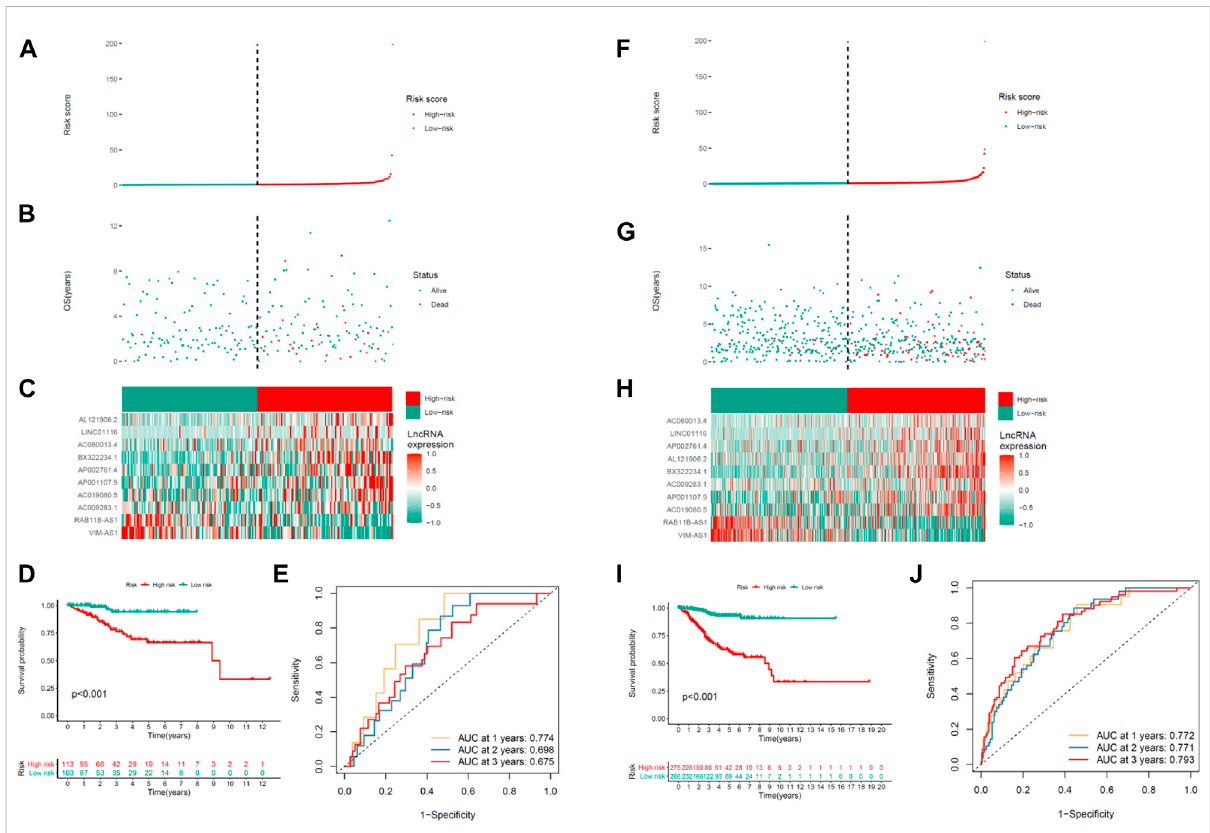
FIGURE 3 Prognosisabilityoftheriskmodelofthe10COVID-19 – associatedlncRNAsinthetestingandwholesets.Distributionoftheriskscore,OS,gene expression, survival analysis, and ROC curves for forecasting OS in the (A – E) testing set and (F – J) entire